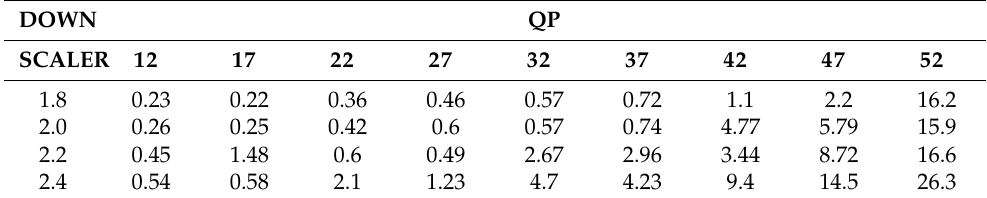
Table 3. Barcode localization error (cm) against QP and down